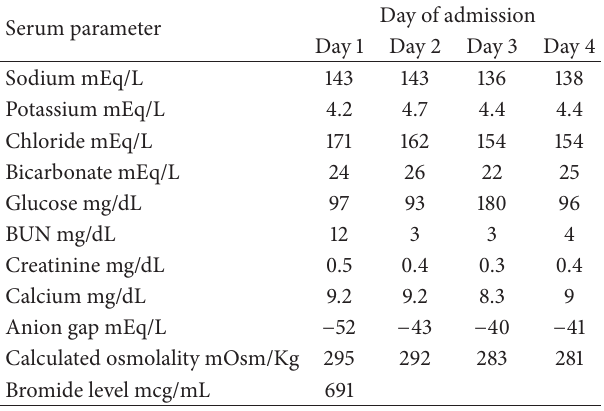
Table 1: This table shows serial electrolytes, anion gap, and calcu- lated serum